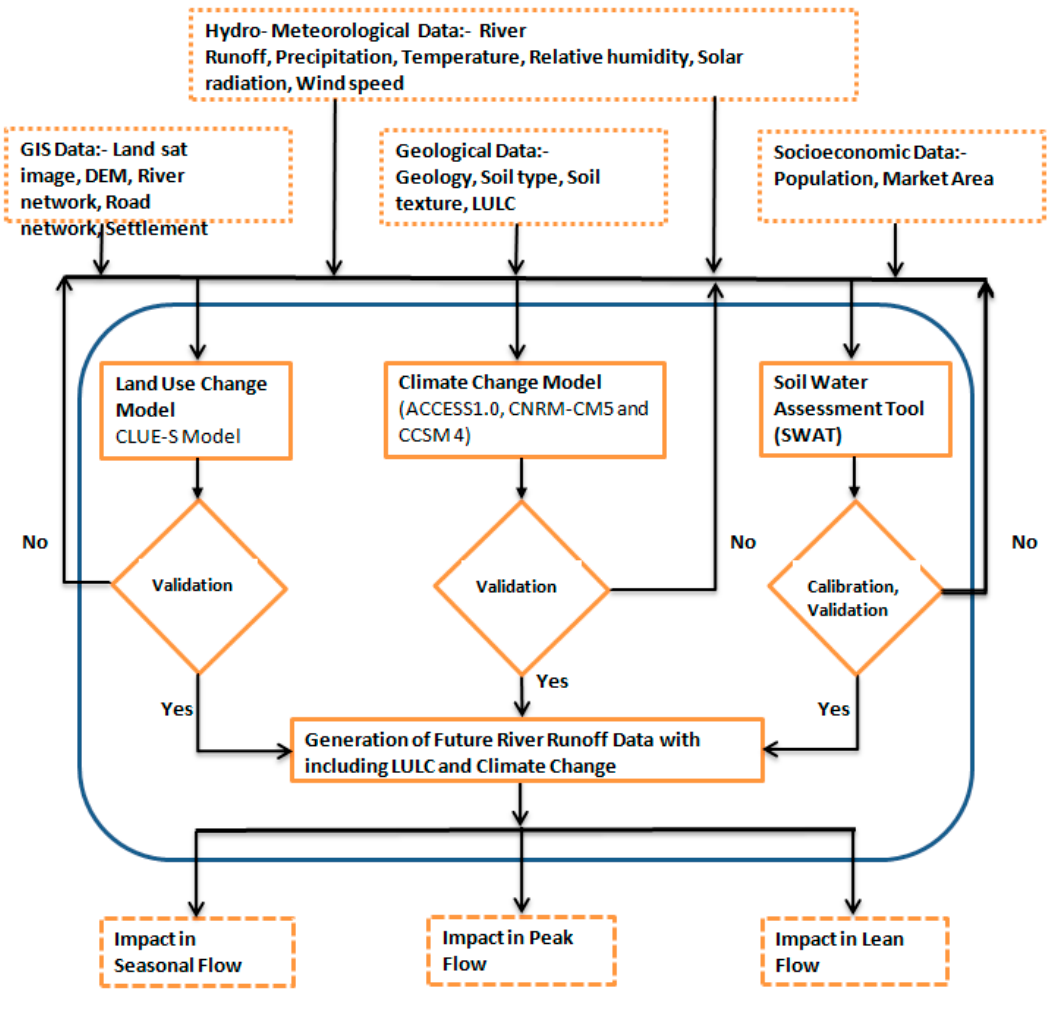
Figure 2. Flowchart of the methodology.